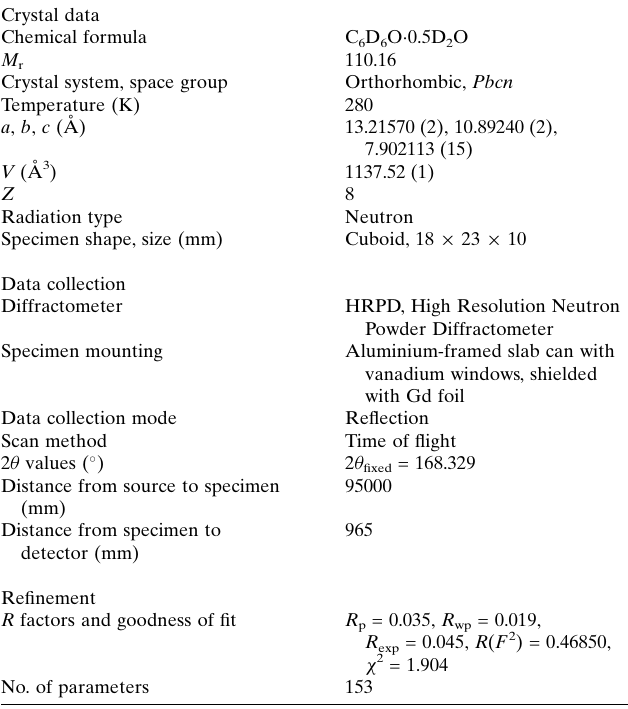
Table 2 Experimental details. Crystal data Chemical